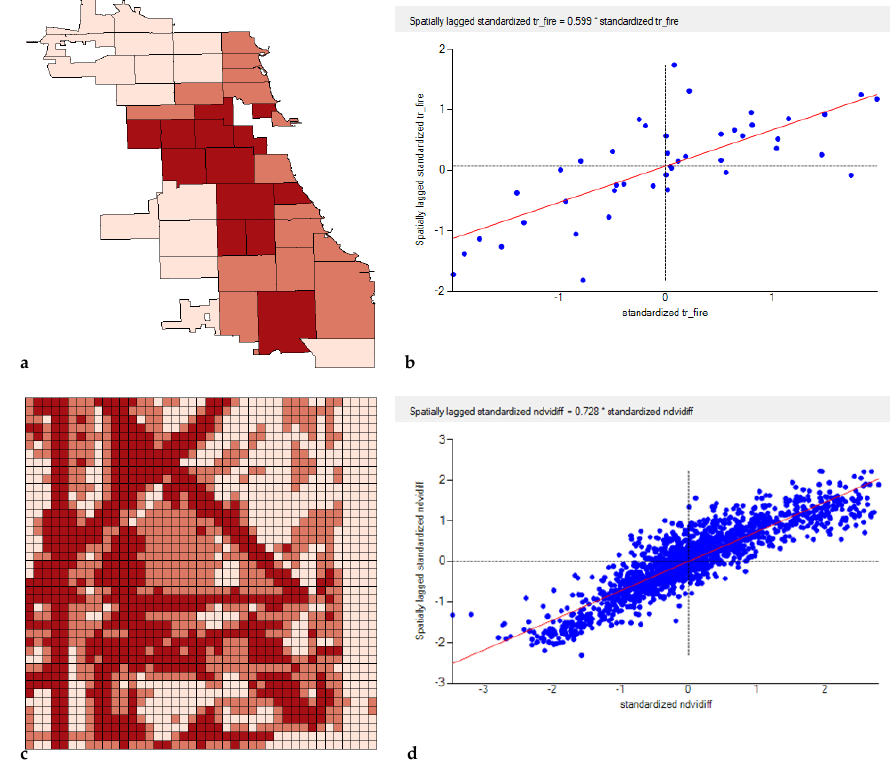
Figure 3. Selected publicly available spatial series dataset visualizations. Tertile (light brown denotes relatively small values, medium brown denotes intermediate values, and dark brown denotes relatively large values) map portrayals of spatial series and their corresponding Moran scatterplots. Top left ( a ): Box-Cox transformed fire insurance rates from Andrews and Herzberg [17], Table 67.1. Top right ( b ): A Moran scatterplot for Figure 3a. Bottom left ( c ): NDVI differences between pre- and post-Harvey (this hurricane struck during 26–30 August 2017) for a specimen region of the Houston metropolitan area. Bottom right ( d ): A Moran scatterplot for Figure 3c.